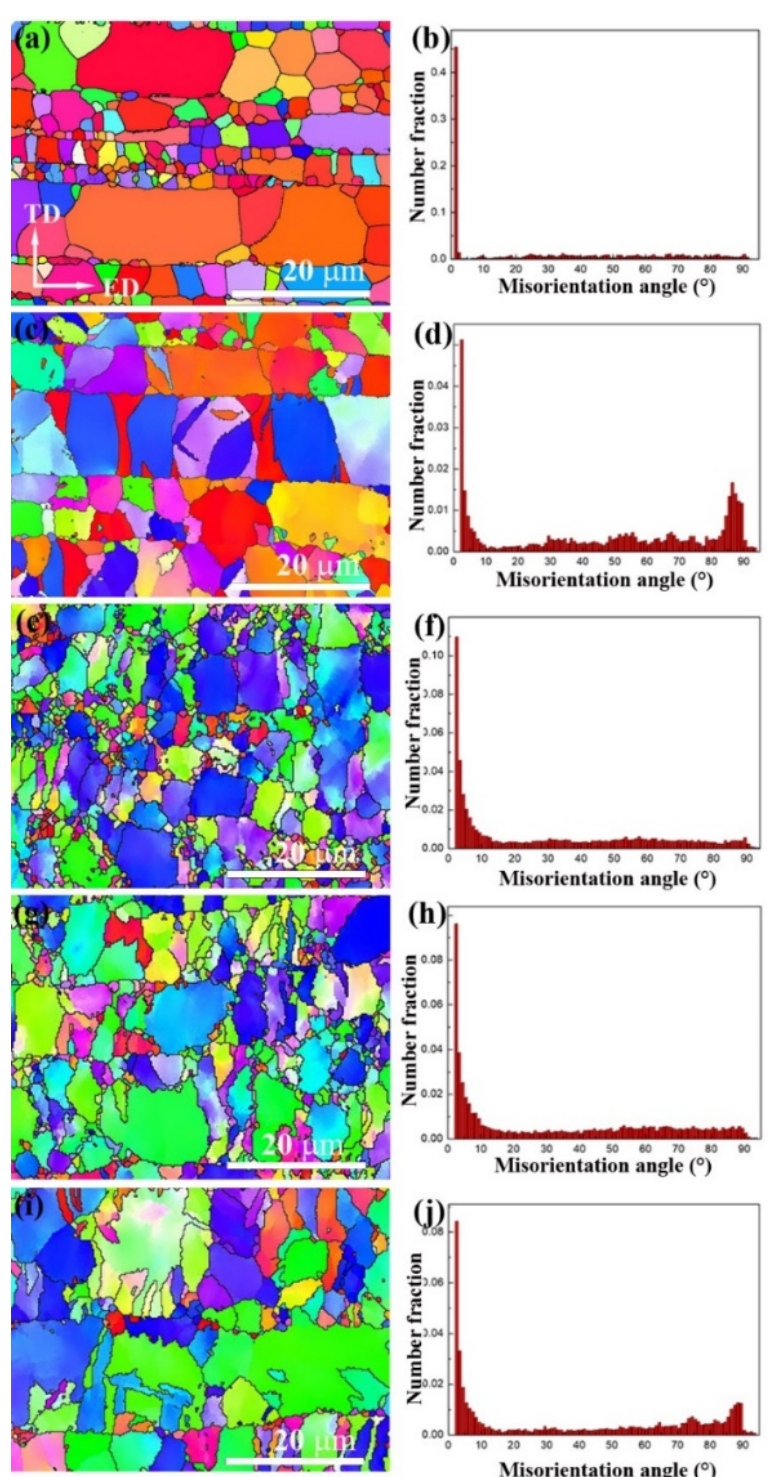
Figure 7. EBSD diagrams and misorientation angle distribution maps of the as-extruded 0.05 wt.% ND/ZK60 composite at the deformation temperature of 200 °C and strain rate of 1 s −1 with different strains: ( a , b ) 0, ( c , d ) 10%, ( e , f ) 20%, ( g , h ) 30%, and ( i , j ) 40% .